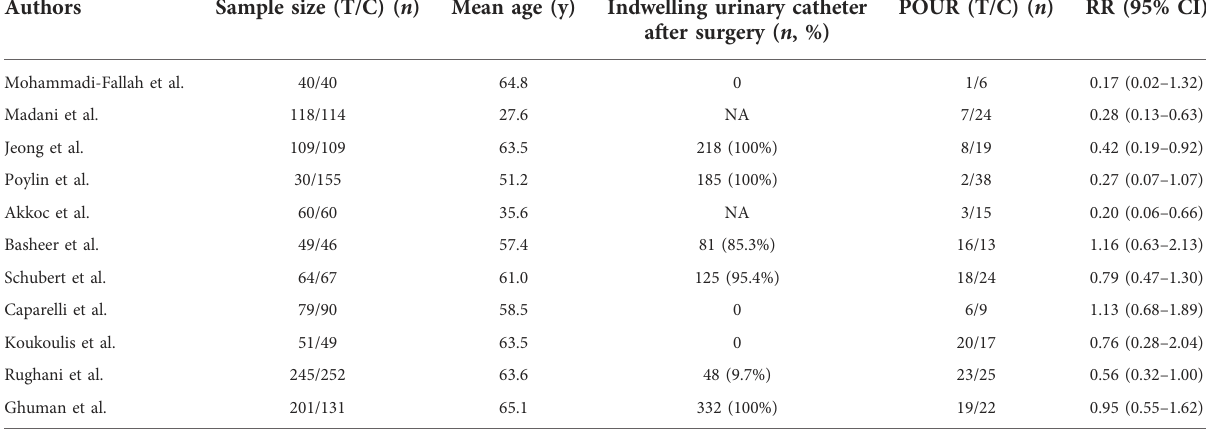
TABLE 2 Patient attributes of included studies.